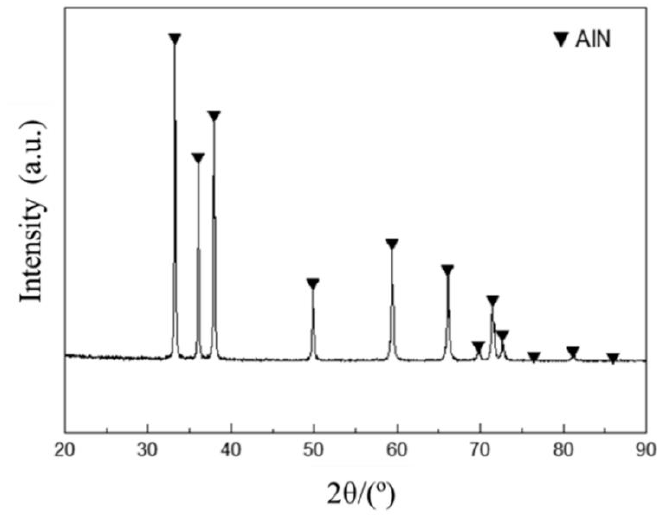
Figure 2. XRD pattern of AlN powder.